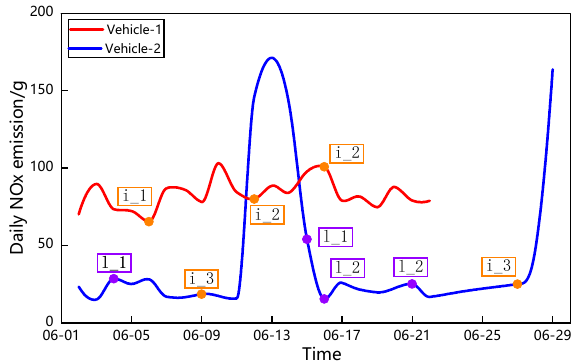
Figure 3. NOx emissions of two vehicles in June.